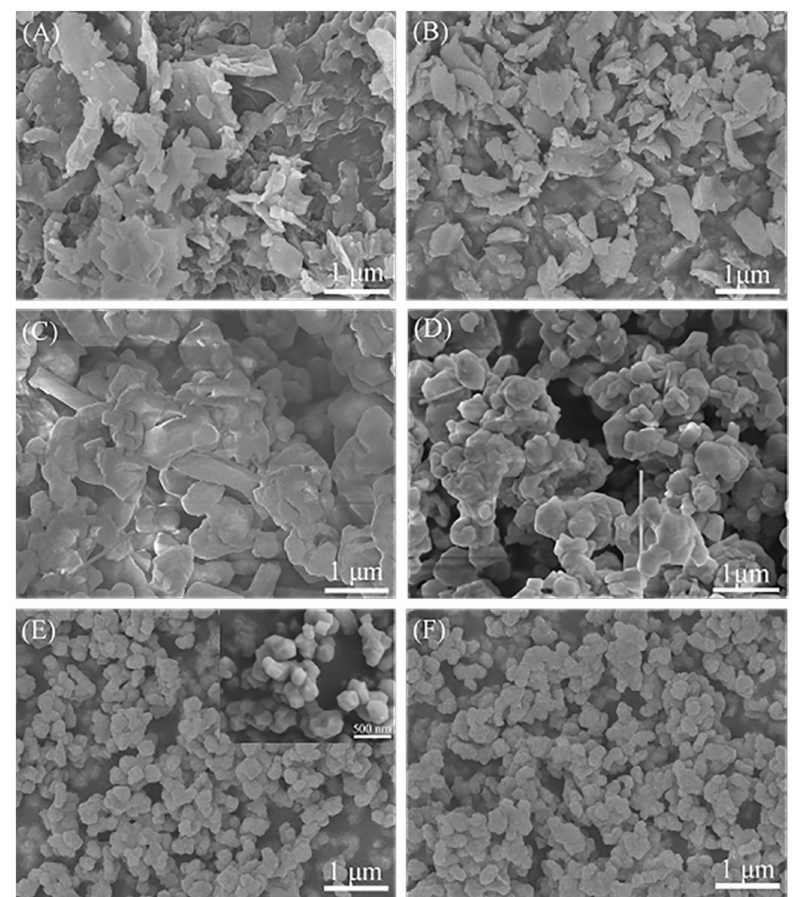
Figure 2. Scanning electron microscope images of the raw silicon ( A ) and the nitridation products obtained at 1300 ◦ C under NH 3 atmosphere with di ff erent contents of CaF 2 additive ( B ) 0 wt% CaF 2 ; ( C ) 1 wt% CaF 2 ; ( D ) 3 wt% CaF 2 ; ( E ) 4 wt% CaF 2 ; ( F ) 7 wt% CaF